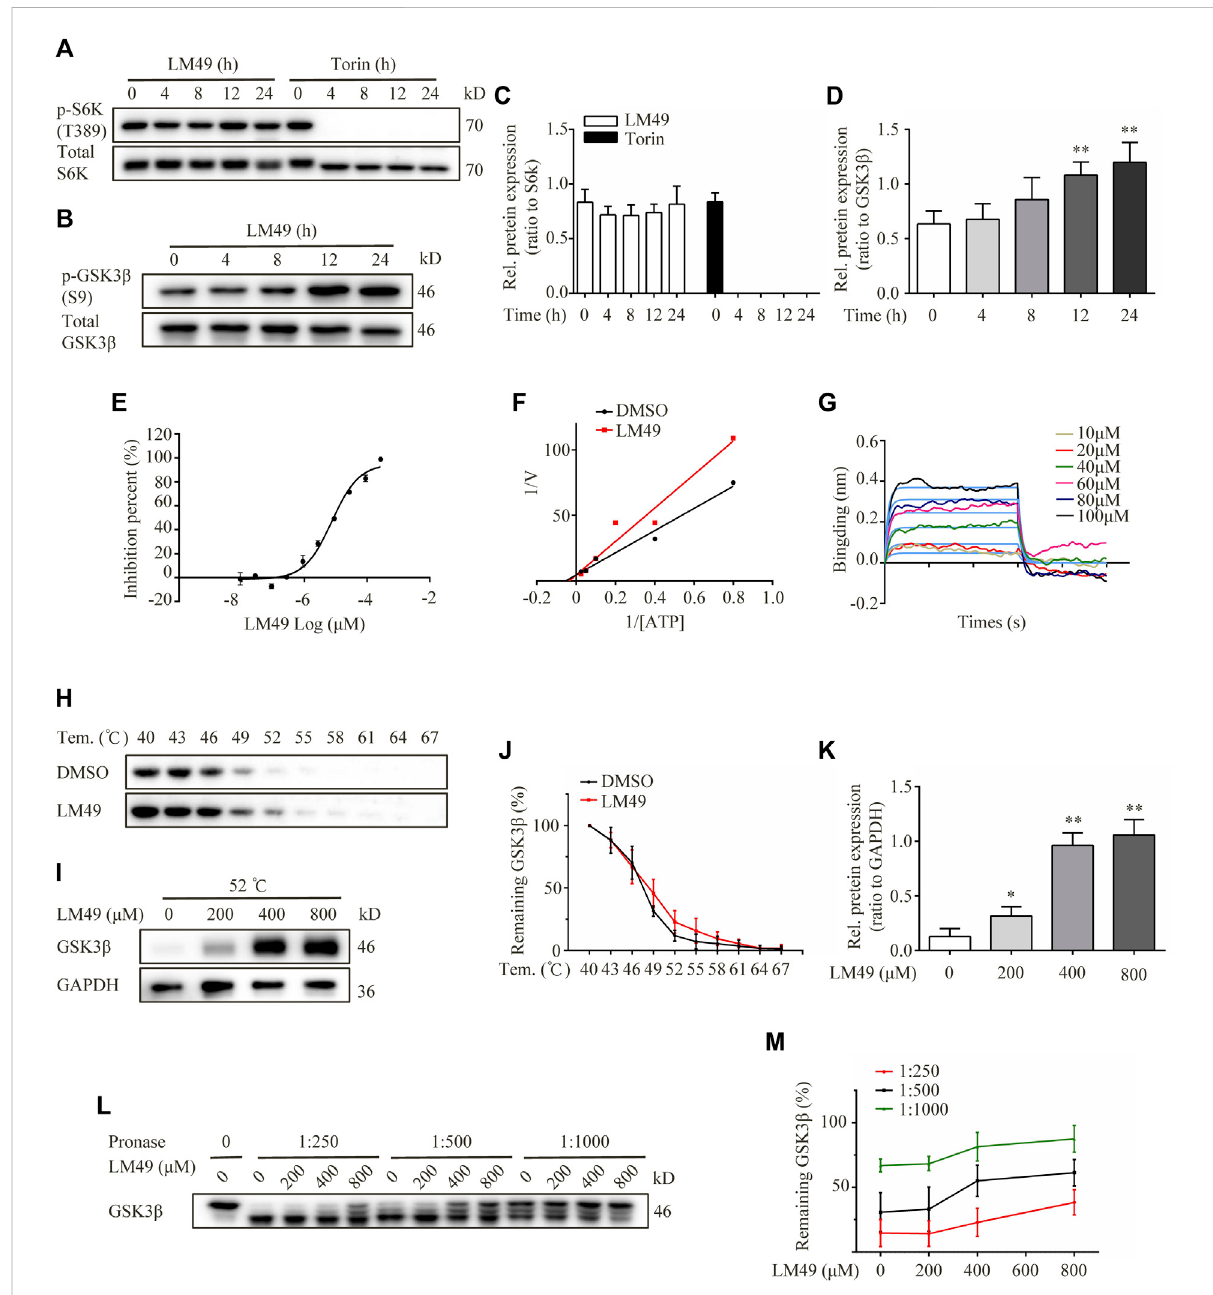
FIGURE 5 LM49 is a new GSK3 β inhibitor. (A) Immunoblot analysis of phosphorylation of S6K in NRK49F cells treated with LM49 (20 μ M) or Torin1 (1 μ M) fortheindicated timepoints. (B) Immunoblot analysis ofphosphorylation ofGSK3 β inNRK49F cellstreatedwith LM49 (20 μ M)for theindicatedtime points. (C) Quanti fi cationofphosphorylationofS6Kin (A) .(n=3). (D) Quanti fi cationofphosphorylationofGSK3 β in (B) .** p < 0.01comparedwith0 h group(n=3). (E) KinaseactivityofGSK3 β indifferentconcentrationsofLM49. (F) Lineweaver-Burkplots. (G) BLIanalysistomeasuredissociation kinetics of LM49 toward GSK3 β . (H) CETSA con fi rms the direct binding of LM49 to GSK3 β in various temperatures. (I) CETSA con fi rms the direct binding of LM49 to GSK3 β in the presence of increasing concentrations of LM49. (J) Quanti fi cation of GSK3 β intensity in (H) . Each group was normalisedasapercentageofthatat40 ° C.(n=3). (K) Quanti fi cationofGSK3 β intensityin (I) .* p < 0.05,** p < 0.01comparedwith0 μ Mgroup(n=3). (L) DARTS con fi rms the direct binding of LM49 to GSK3 β . (M) Quanti fi cation of GSK3 β intensity in (L) . Each group was normalised as a percentage of that without pronase. (n =